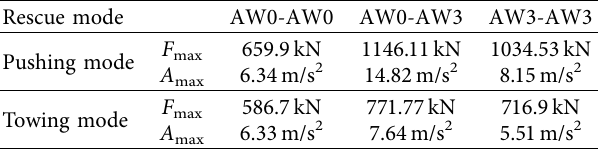
Figure 6: Coupler forces when AW0 rescues AW3. (a) Maximum coupler force. (b) Time history of coupler forces. Table 6: Maximum values of longitudinal dynamics.